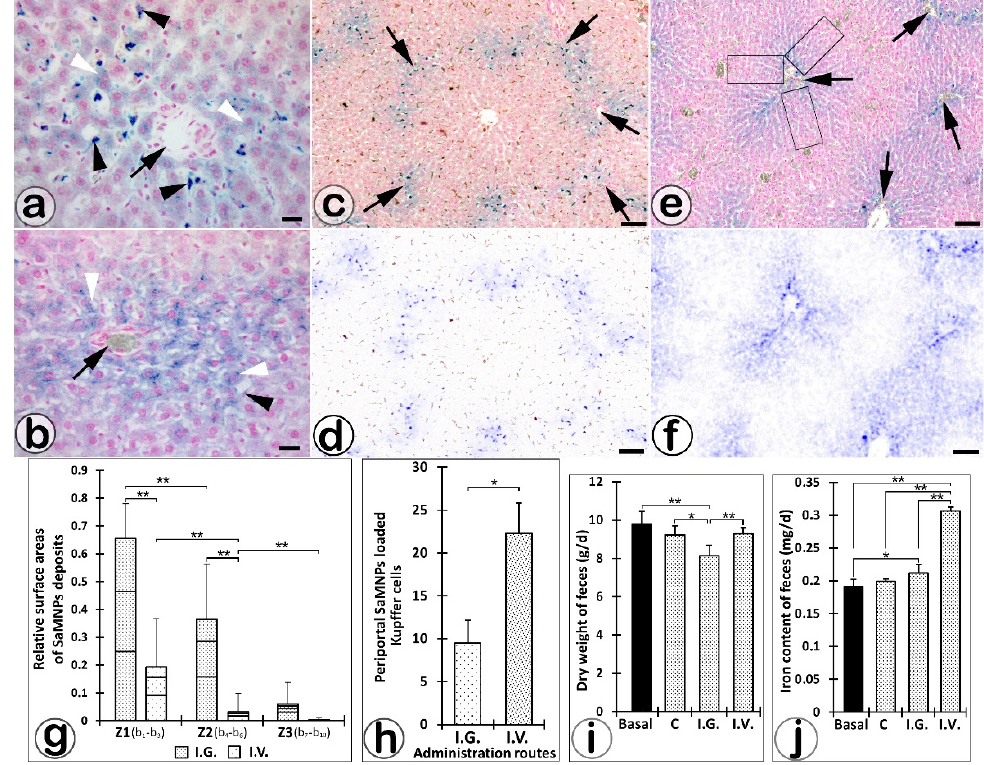
Figure 3. Microscopy of the intracytoplasmic SaIONP deposits in hepatocytes (white arrowheads) and Kupffer cells (black arrowheads) located around the portal areas (black arrows) of the liver parenchyma harvested 24 h after IV ( a ) or IG ( b ) SaIONPs’ administration. The SaIONPs’ specific loading patterns of hepatic acini after IV ( c , d ) or IG ( e , f ) administration revealed by multispectral camera analysis (the boxes indicate the selected and analyzed areas around a portal space). Different zonal distribution of SaIONP deposits in periportal areas ( g ) and periportal Kupffer cells ( h ) relative to IV or IG routes of SaIONPs administration. Variation of dry weight ( i ) and total iron content of the feces after the IV or IG ( j ) SaIONPs’ administration (* p < 0.05; ** p < 0.01; ( g – i ) one-way ANOVA with post hoc Tukey test; ( h ) Student’s t -test). Perls Prussian blue ( a , b , c , e ) and anti-Iba-1 ( c , d ) stainings. Bar = 10 µm ( a , b ); 50 µm ( c – f ).